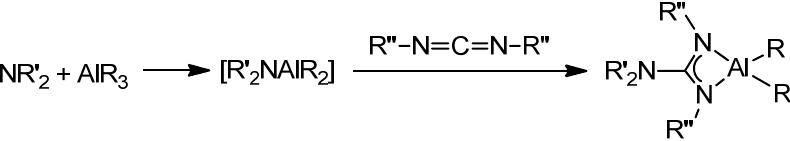
Figure 18. Insertion of carbodiimides into Al–N bonds of amido compounds.